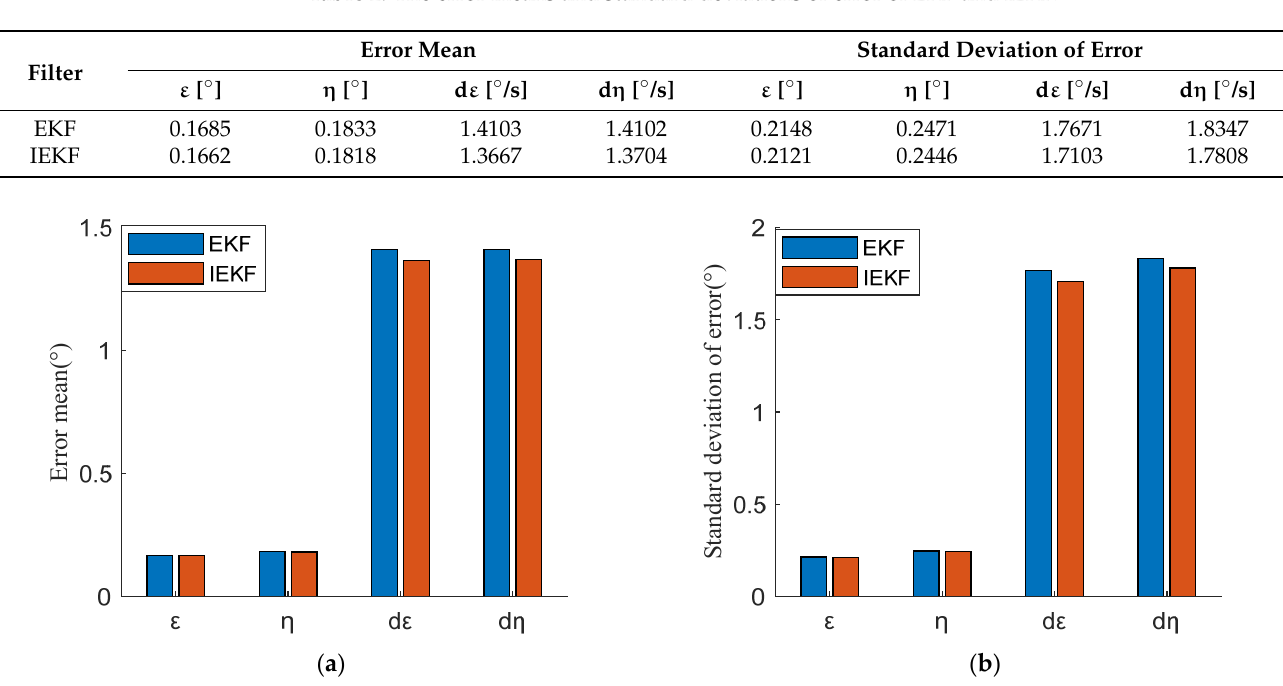
Table 2. The error means and standard deviations of error of EKF and IEKF.